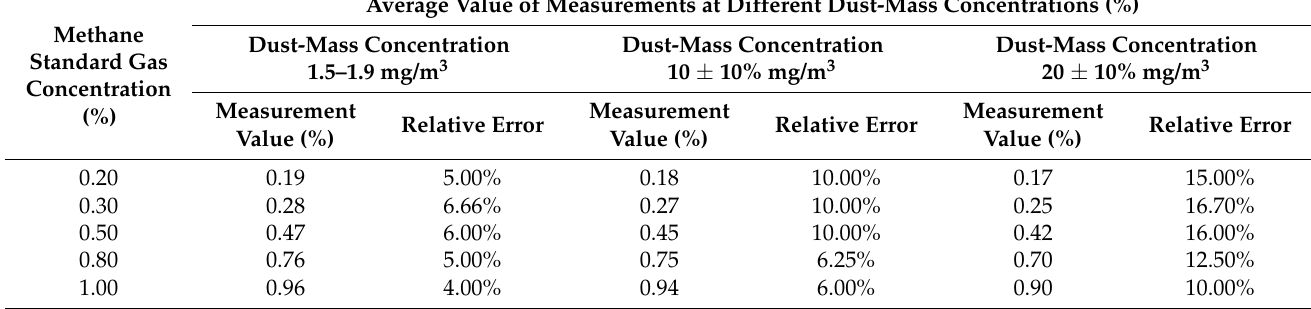
Table 5. Influence of dust-mass concentration on the TDLAS methane sensor.